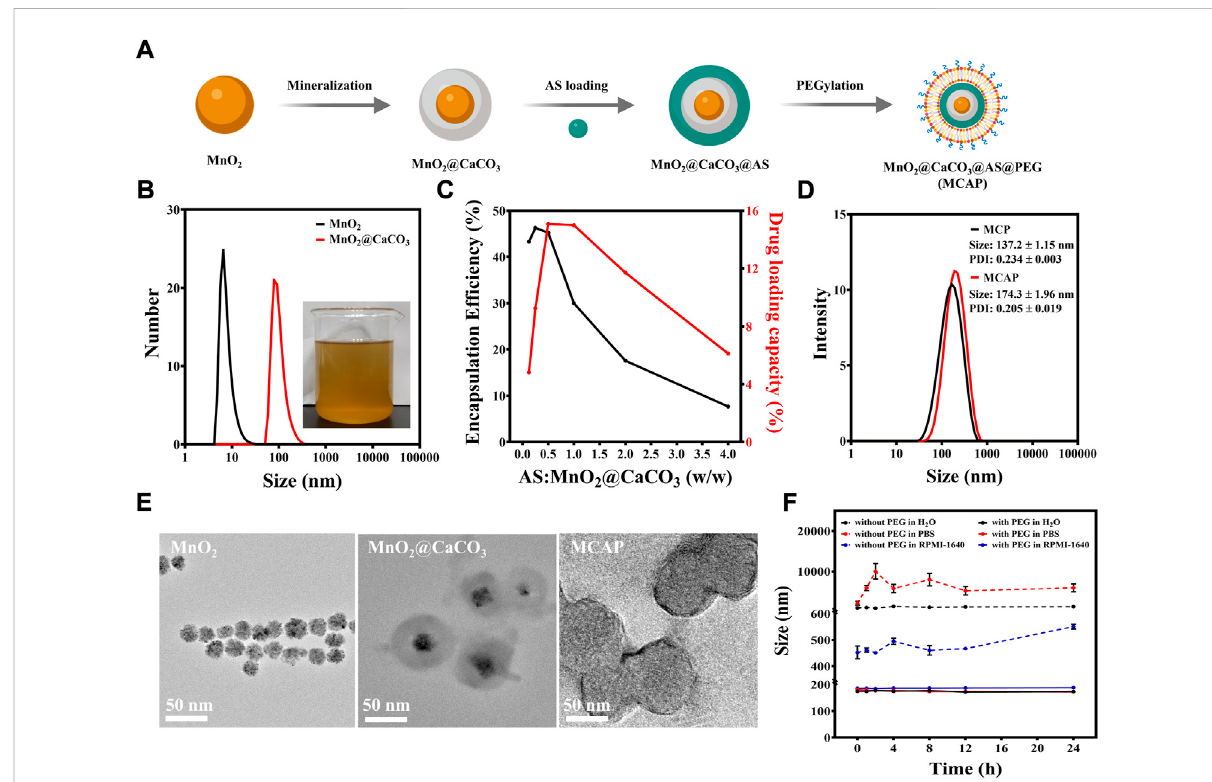
Preparation and characterization of MCAP NPs. (A) The preparation procedure of MCAP NPs. (B) DLS measurements of MnO 2 and MnO 2 @